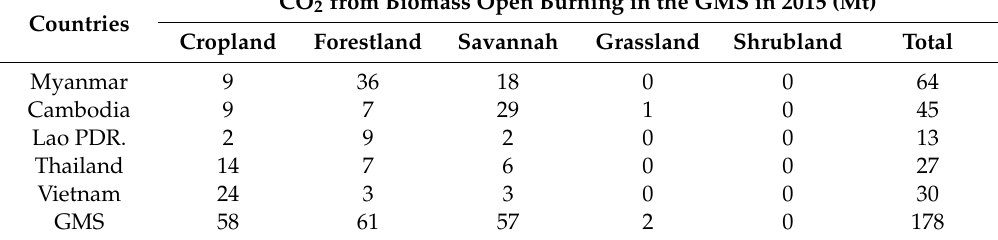
Table A1. The actual amount of CO 2 from biomass open burning classified by vegetation types in the GMS in